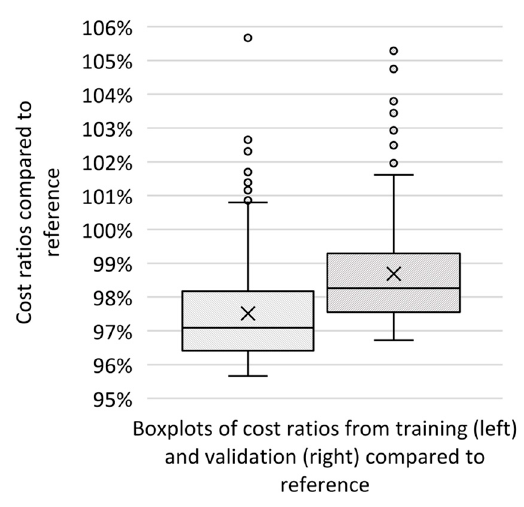
Figure 7. Boxplot of cost ratios of the operating costs applied on training and validation dataset.